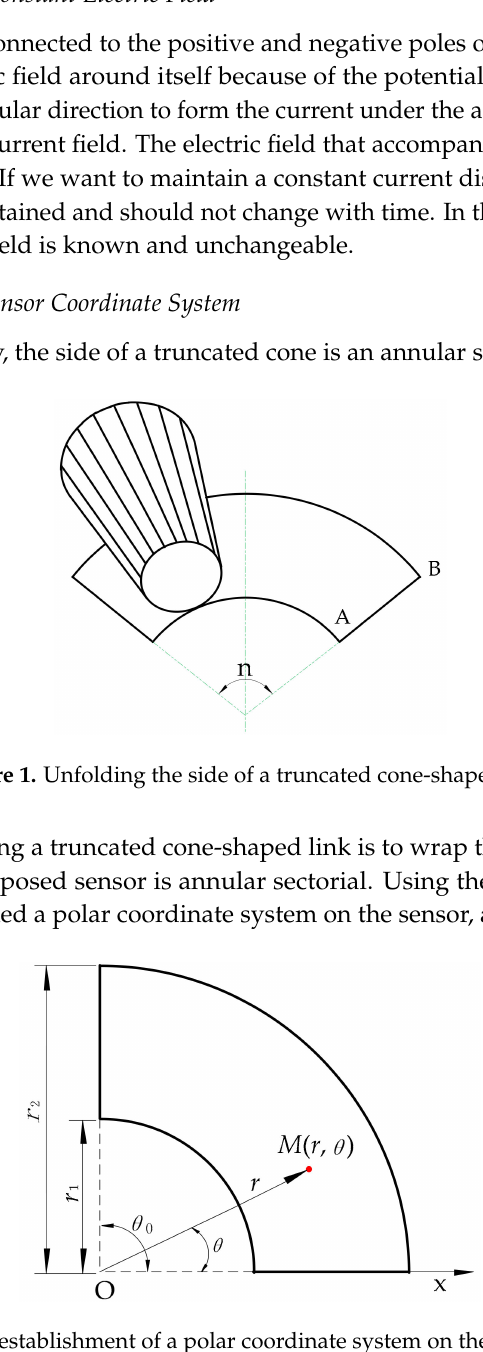
Figure 2. The establishment of a polar coordinate system on the annular